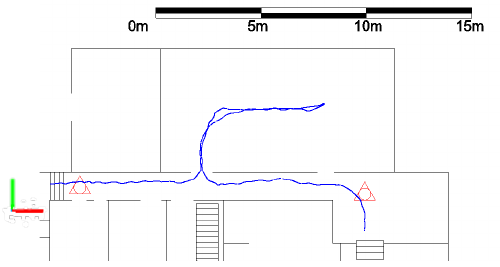
Figure 11. Representation of signed distances for loop 1.